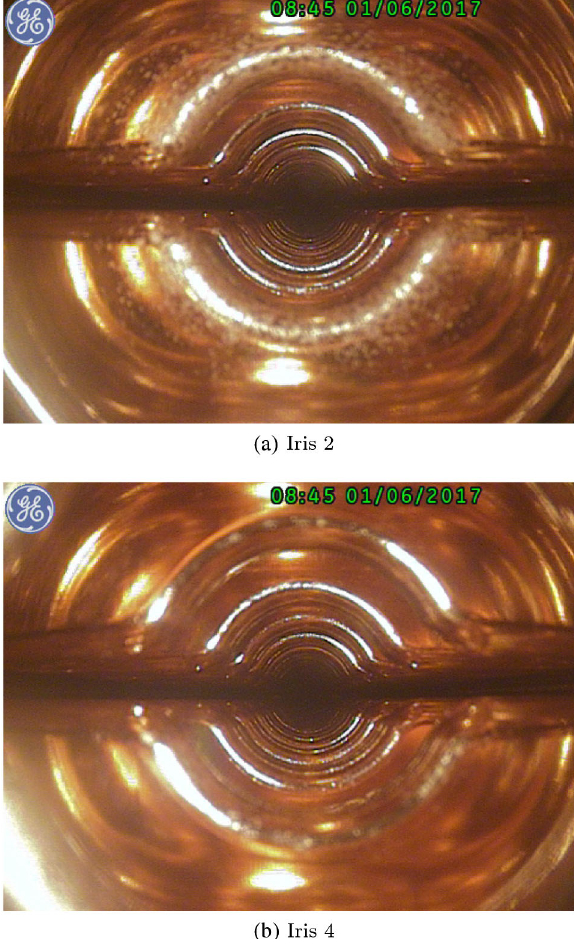
FIG. 16. Borescope images from the structure after condition- ing. The location of the irises is described in Fig. 14.